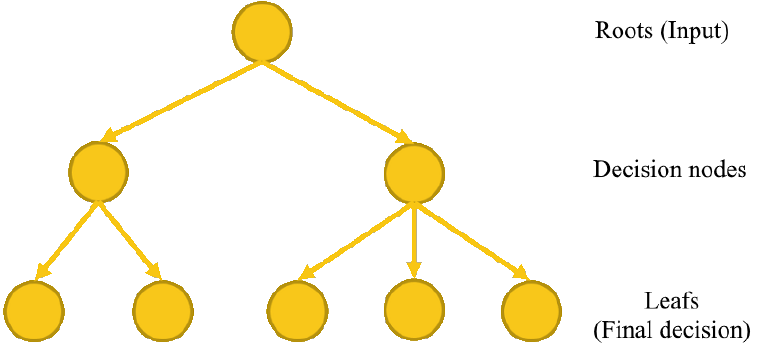
Figure 8. Decision tree structure.